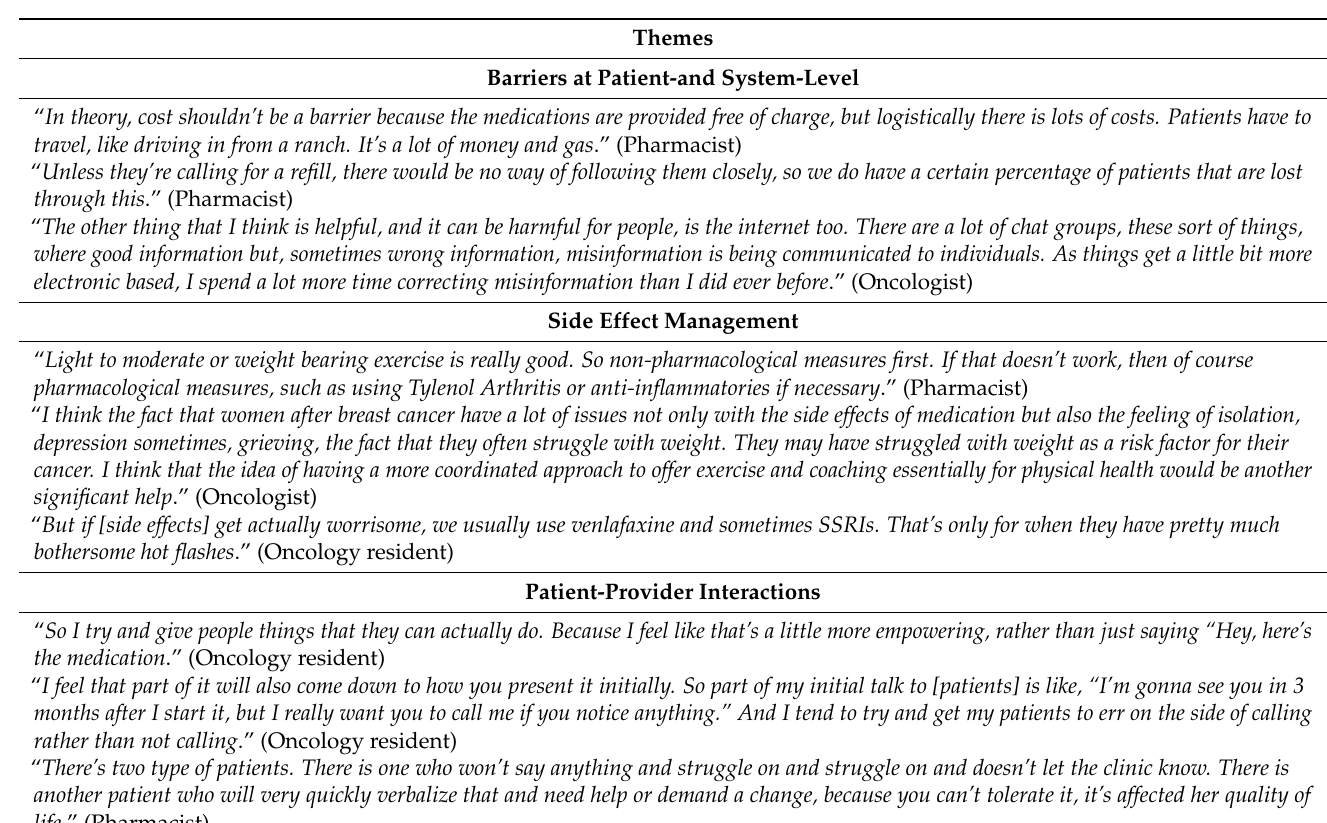
Table 4. Additional quotes from healthcare